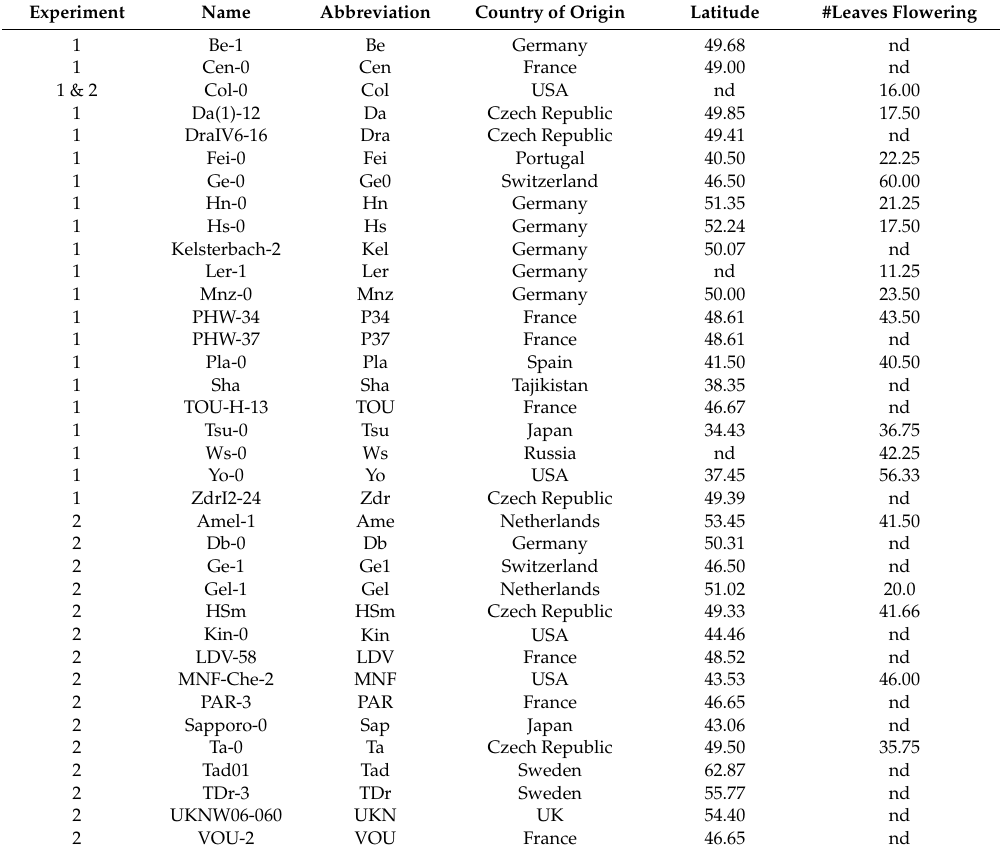
Table 1. Full names and abbreviations (as used in the figures) of Arabidopsis accessions. Accessions are sorted by the fluctuating light (FL) experiment they were used in. Information on country of origin, latitude, and number of leaves at flowering was accessed on the 1001 genomes website (https: // 1001genomes.org / ). nd = not